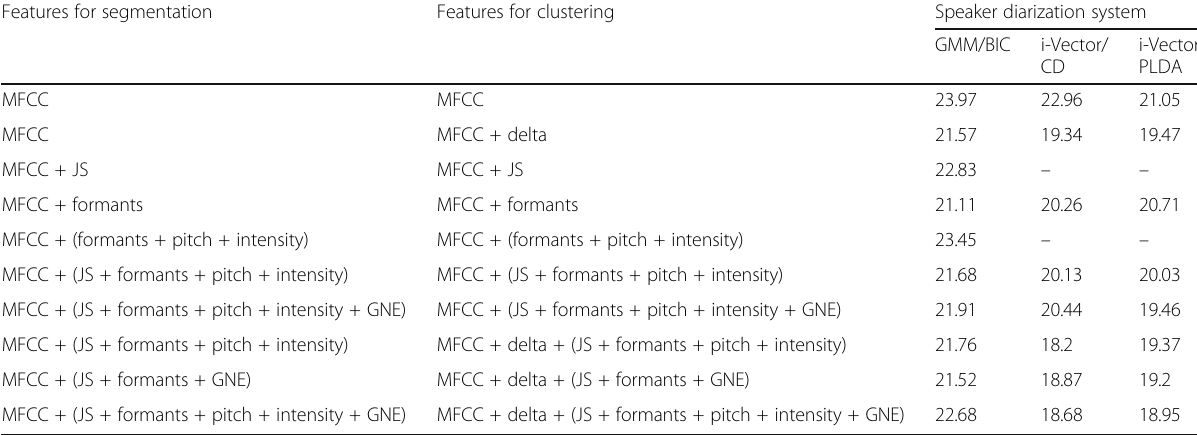
Table 1 DER of the test set using the proposed long-term speech features and proposed speaker diarization systems Features for segmentation